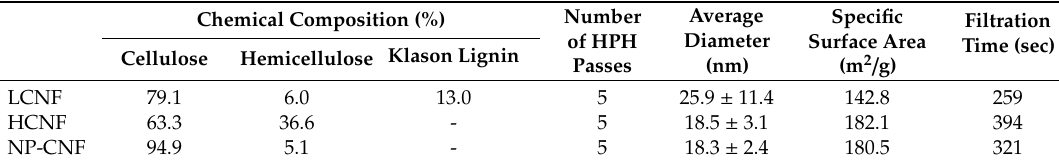
Table 1. Chemical composition, average diameter, specific surface area, and filtration time of lignocellulose nanofibril (LCNF), holocellulose nanofibril (HCNF), and nearly purified-cellulose nanofibril